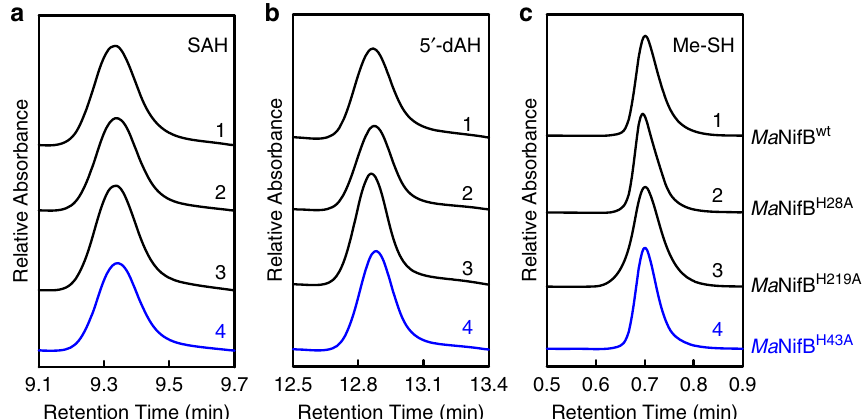
Fig. 3 Functional properties of Ma NifB proteins. a , b HPLC elution pro fi les of SAH ( a ) and 5 ′ -dAH ( b ) upon incubation of SAM with Ma NifB wt (1), Ma NifB H28A (2), Ma NifB H219A (3), and Ma NifB H43A (4). c GC analyses of methanethiol (Me-SH) formation upon acid quenching of incubation mixtures containing SAM and Ma NifB wt (1), Ma NifB H28A (2), Ma NifB H219A (3), and Ma NifB H43A (4). All products were identi fi ed using standards 13,14 . The HPLC ( a , b ) and GC ( c ) experiments were each performed three times independently ( n = 3 independent samples), and representative results are shown in the fi gure. The protein and SAM concentrations are 0.4 mM and 4 mM, respectively, in ( a , b ); and 40 μ M and 0.3 mM, respectively, in ( c ). See Methods for detailed compositions of these